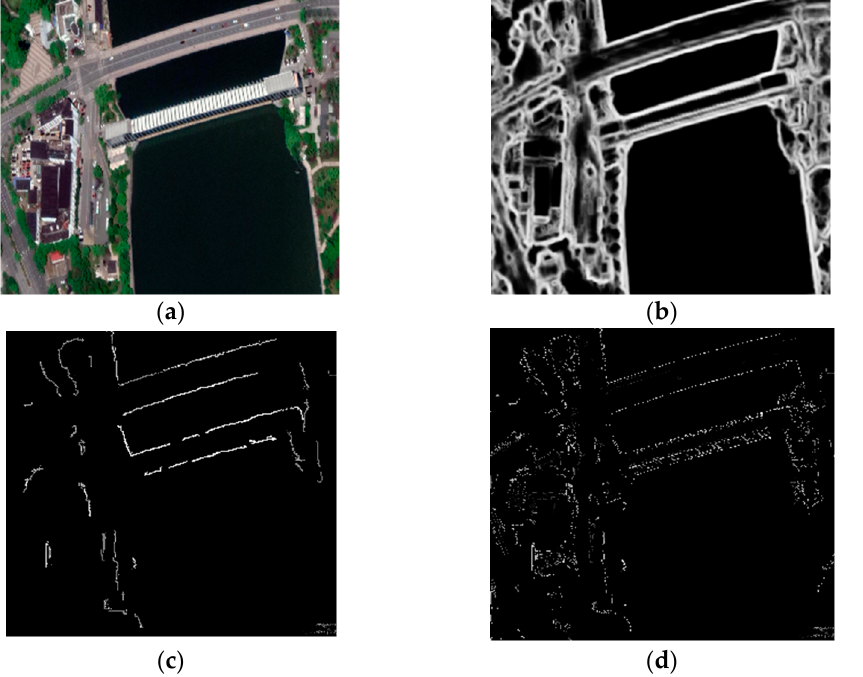
Figure 5. Visible light edge detection results. ( a ) Original image 1 of dam; ( b ) improved HED network image 1 of dam; ( c ) DeepContour image 1 of dam; ( d ) the algorithm in this paper image 1 of dam.